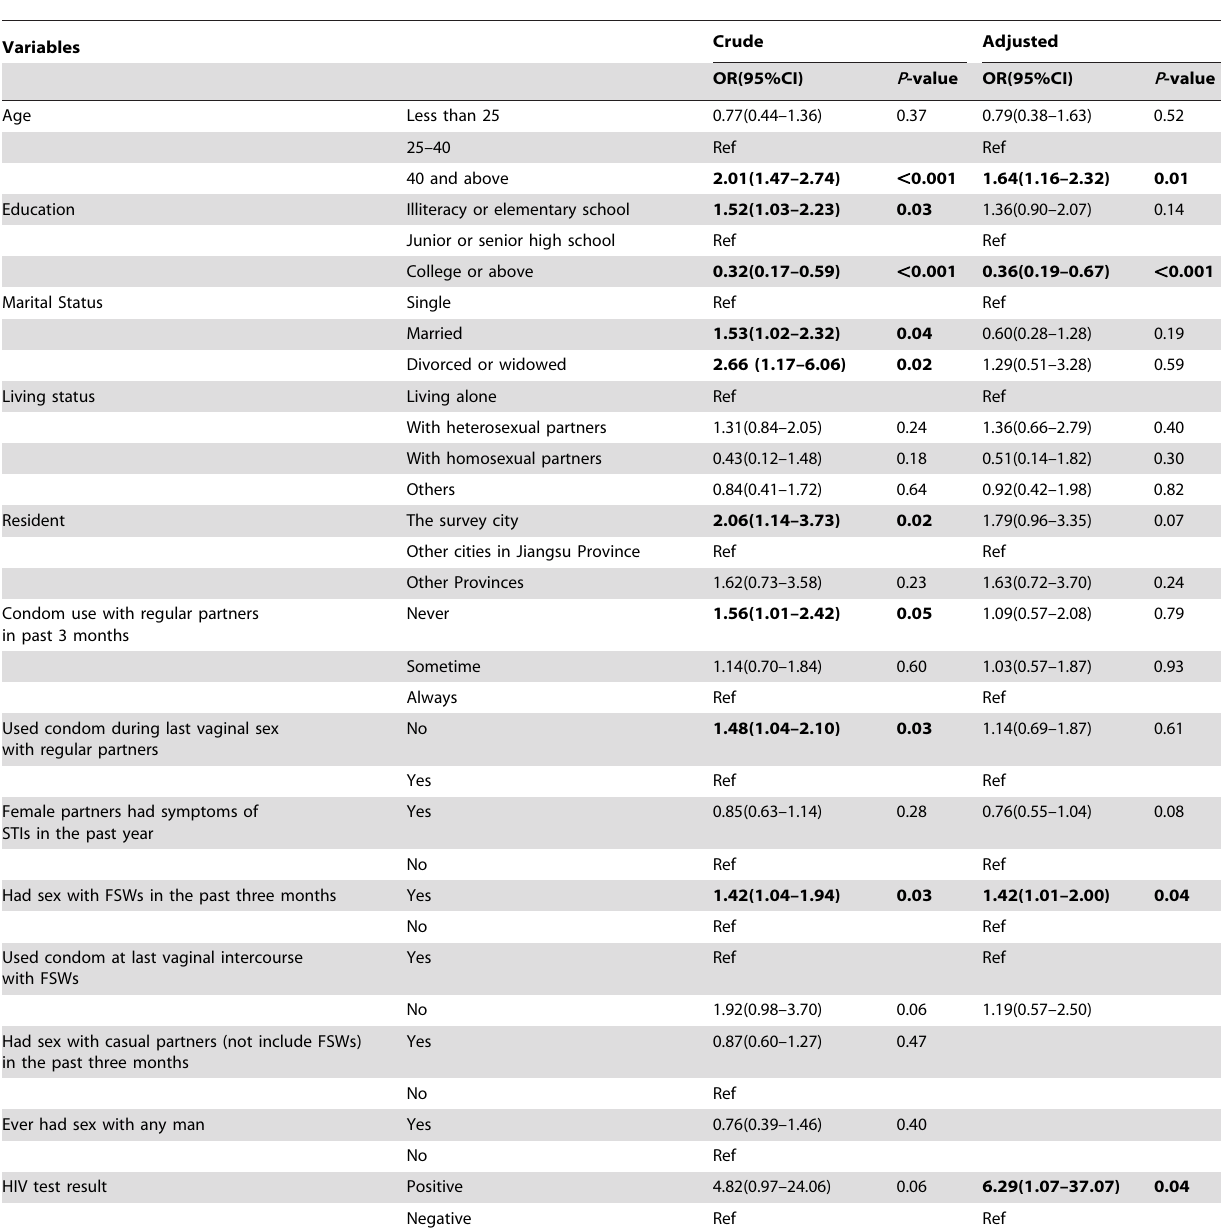
Table 3. Factors correlated with syphilis among heterosexual male attendees of STI clinics (MSC) in Yangzhou and Changzhou cities of Jiangsu Province, China,